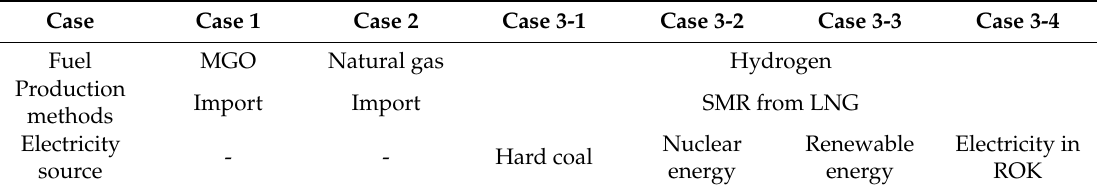
Table 1. Cases of alternative fuels for ship in the study.